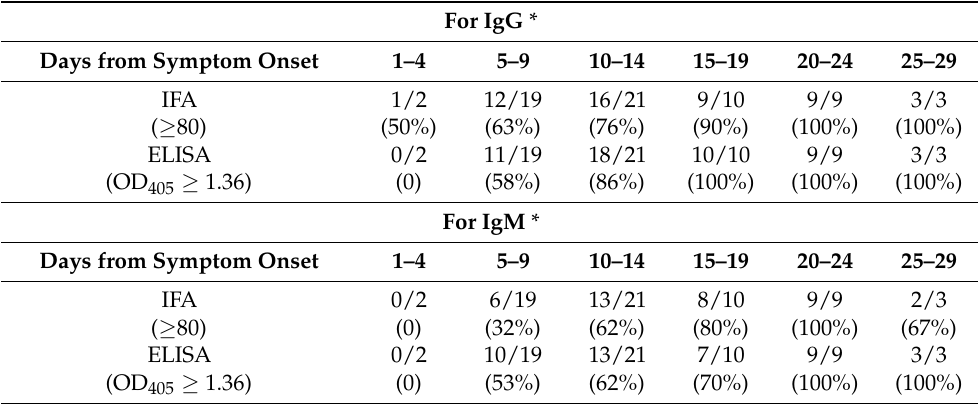
Table 2. Seropositive rates of SFTSV-IgG and -IgM based on patients’ clinical course of disease.